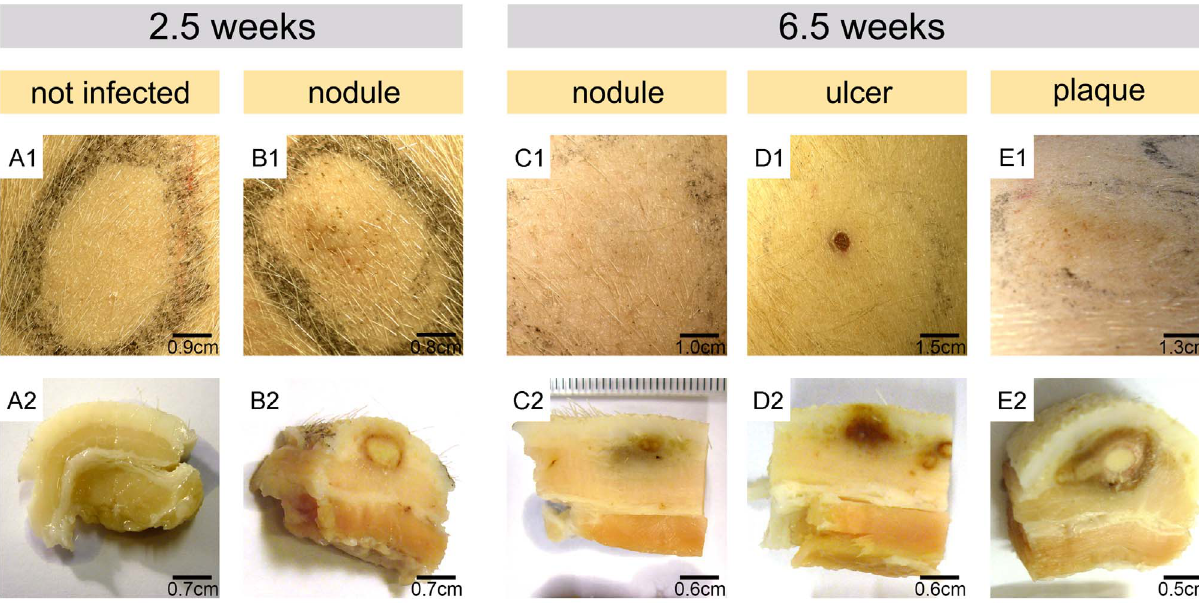
Figure 1. Macroscopic appearance of pig skin infected with M.ulcerans . Development of representative lesions 2.5 weeks or 6.5 weeks after subcutaneous infection with 2 6 10 7 (B1, D1 and E1) or 2 6 10 6 (C1) CFU is depicted and compared to a site left uninfected (A1). Excised tissue specimens were fixed and vertically cut in half to visualize macroscopically visible alteration in tissue structure (A2–E2). For high inoculation doses ( $ 2 6 10 6 CFU) the formation of nodules (B1) with necrotic centres was observed already 2.5 weeks after infection (B2). These yellow centres indicative for coagulative necrosis were surrounded by a reddish ring (B2). At 6.5 weeks after infection, these nodules had progressed into a small ulcer or a plaque (D1, E1) associated with marked macroscopically visible alterations in tissue structure (D2, E2). At sites injected with 2 6 10 6 CFU nodules with greyish discoloration of the dermis had developed 6.5 weeks after injection of M. ulcerans (C1, C2).